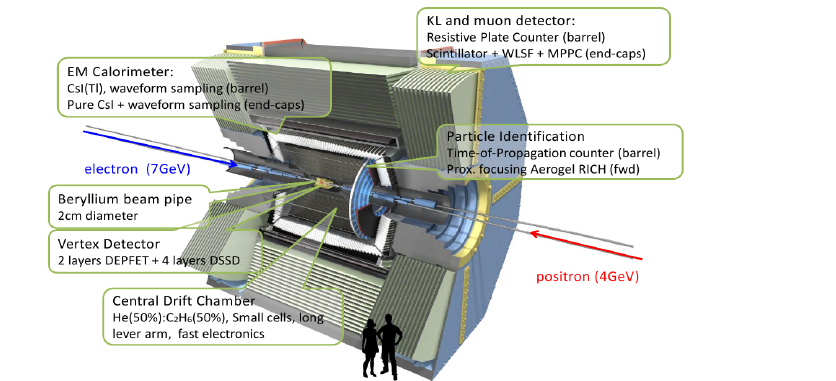
Figure 1. The Belle II detector. From the inside, the pixel detector (PXD), the silicon vertex detector (SVD), and the central drift chamber (CDC) are implemented for the precision particle tracking. The time of propagation counter (TOP) and the aerogel Cherenkov counter (ARICH) are placed outside for particle identification. The detectors are surrounded by the electromagnetic calorimeter (ECL) and the KL and muon detector (KLM).